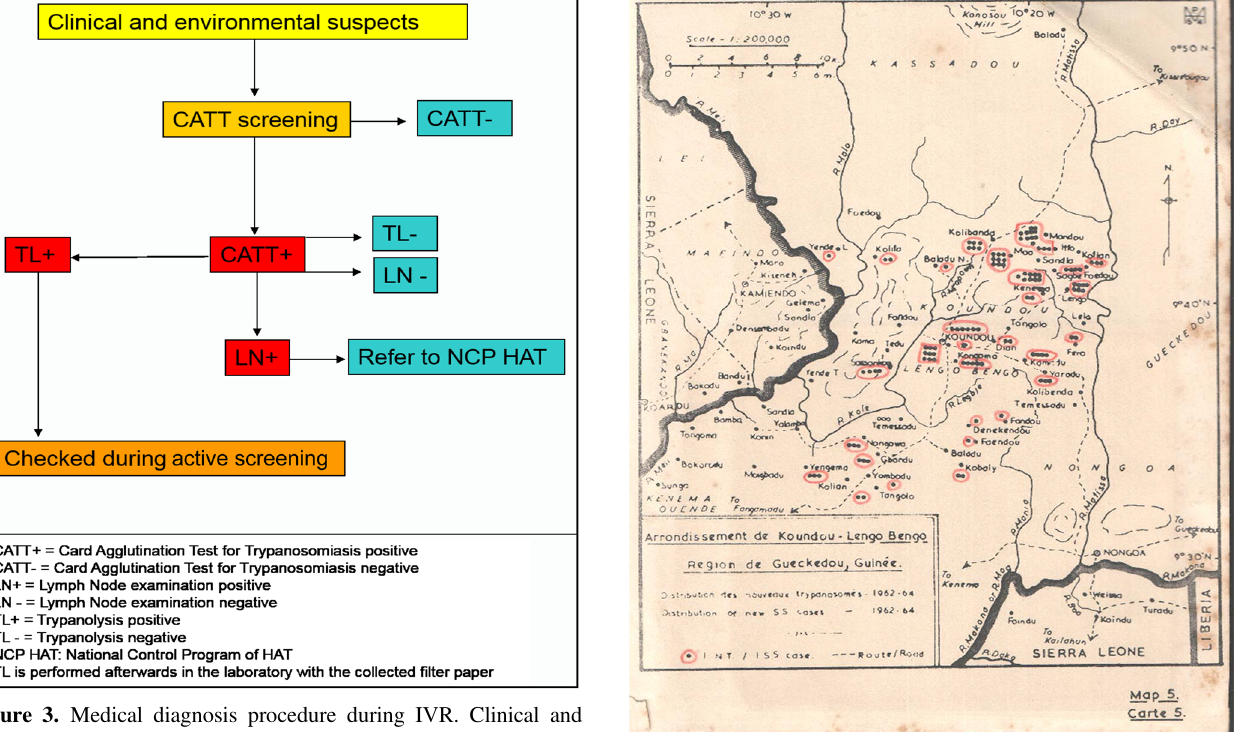
Figure 4. Location of HAT cases diagnosed from 1962 to 1964 in the Koundou Lengo Bengo focus (Gueckedou area). The map displays the distribution of HAT cases diagnosed from 1962 to 1964 in the Koundou Lengo Bengo focus, located in the Gueckedou area. This type of information is crucial in establishing the list of villages at risk of HAT to be visited in the fi eld. Black dots with red circles represent the number of new sleeping sickness cases diagnosed between 1962 and